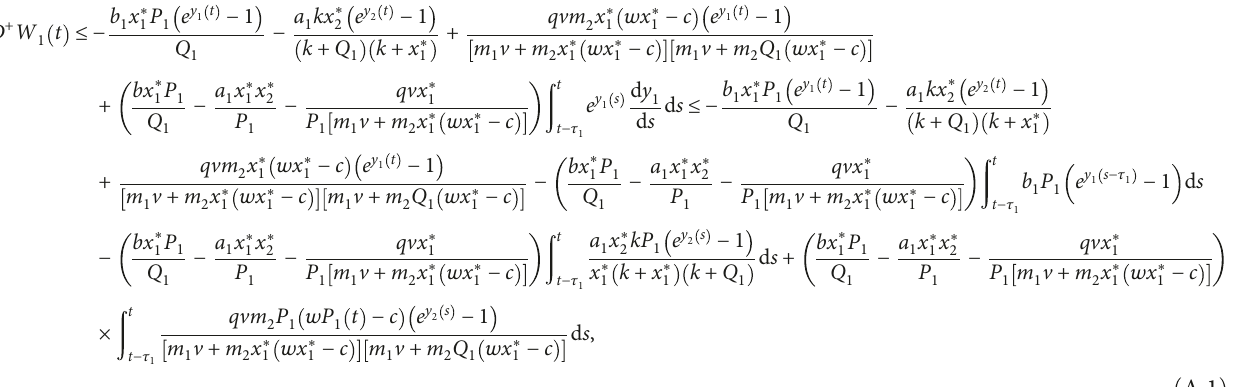
γ = γ = 0 1 and (b) γ 1 2